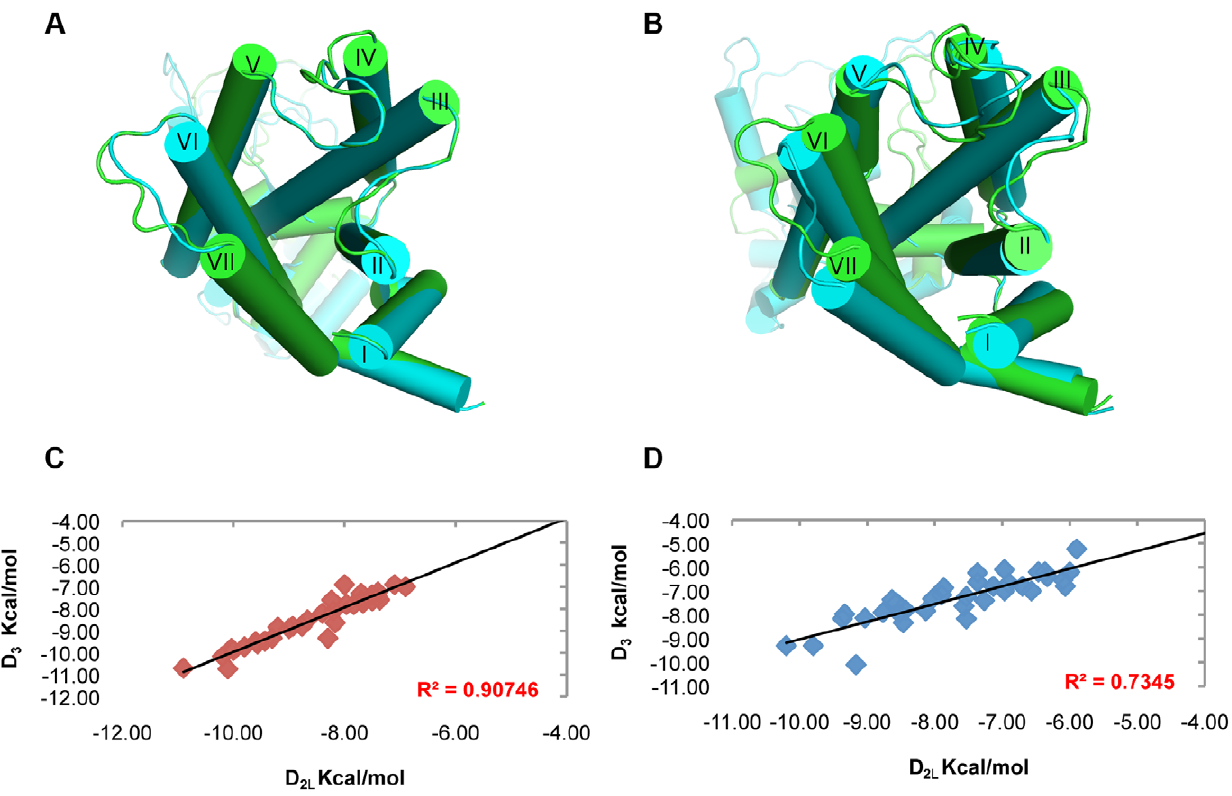
Figure 3. Structure differentiation of hD 3 and hD 2L receptors simulated in membrane. (A) Superimposition of hD 3 (green cartoon) and hD 2 (cyan cartoon) homology models before the refinement with simulation in membrane. (B) structural alignment of hD 3 (green cartoon) and hD 2 (cyan cartoon) receptors after 3 ns of MD simulation in membrane. (C) high correlation of hD 3 and hD 2 binding energies (Autodock Vina) of D 2 -like ligands from homology models without MD refinement. (D) low correlation of hD 3 and hD 2 binding energies (Autodock Vina) of D 2 -like ligands after MD refinement.